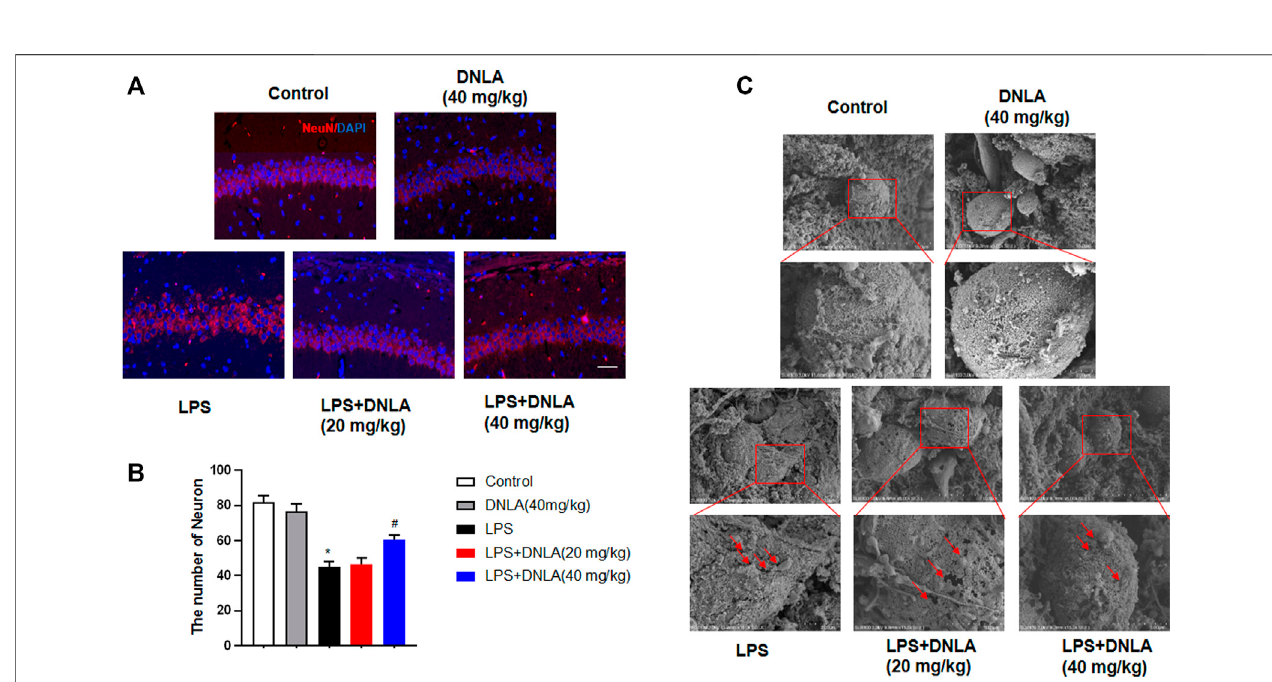
FIGURE 2 | DNLA attenuated LPS-induced hippocampus neuronal damage. After DNLA treatment for 14 days, the neuronal quanti fi cation in hippocampus CA1 wasmeasured byimmuno fl uorescencestaining.Thered colorindicatedNeuN-positivecells,and thebluecolorshowedaDAPI-stained nucleus. Scalebar=50 μ m (A) . Quantitative analysisofthenumber ofNeuN-positivecells (B) .Cell membranestructure ofhippocampal neuronswas observed using thescanning electron microscope (C) . * p < 0.05 compared with the control group; # p < 0.05 compared with the LPS-treated group. Data were expressed as mean ± SEM from four mice.